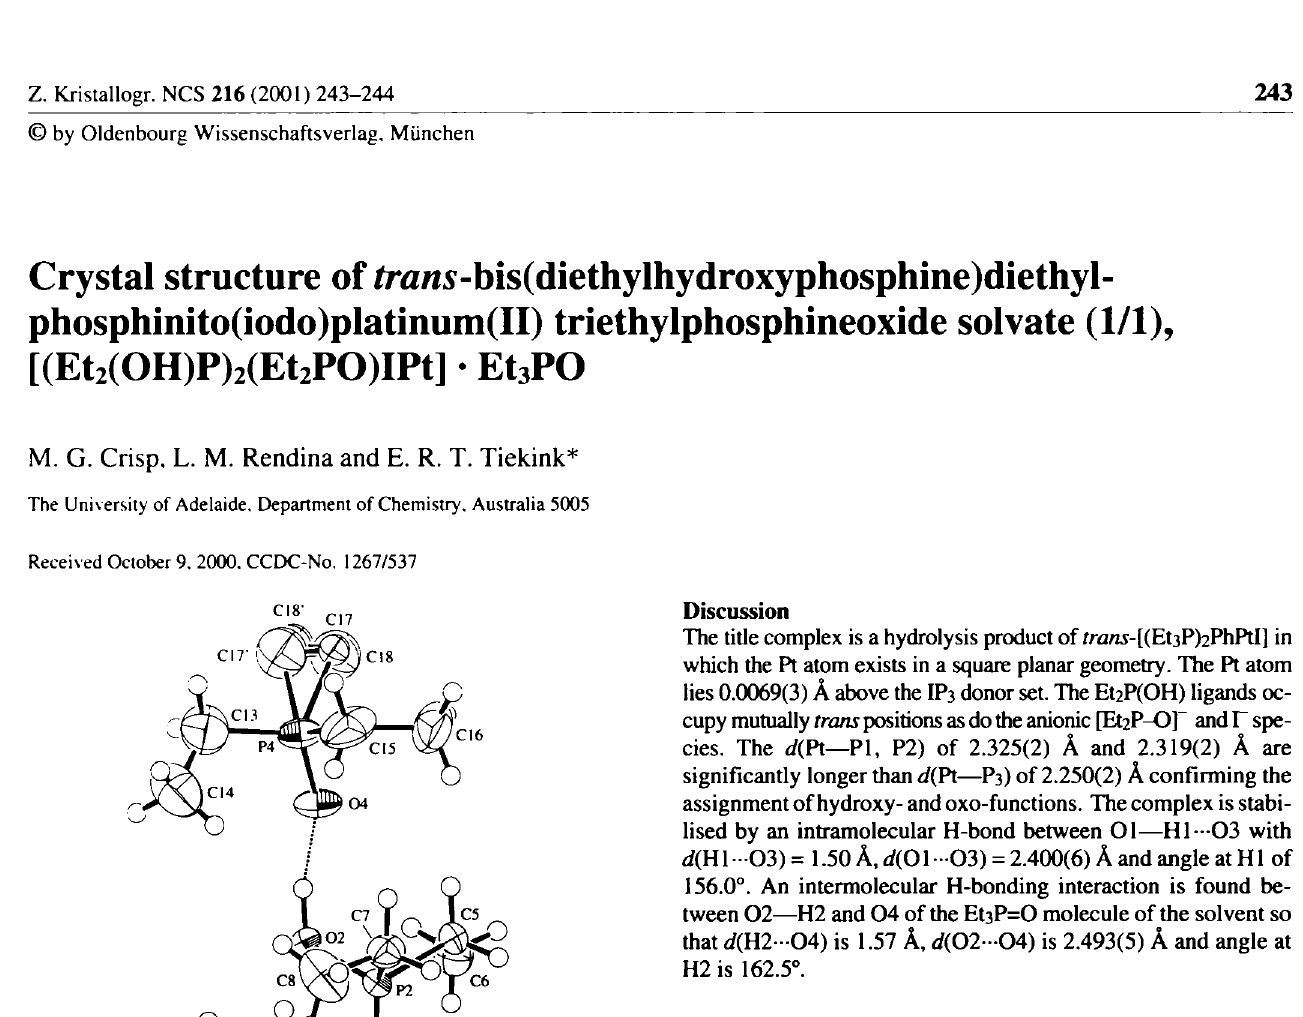
Table 1. Data collection and handling.